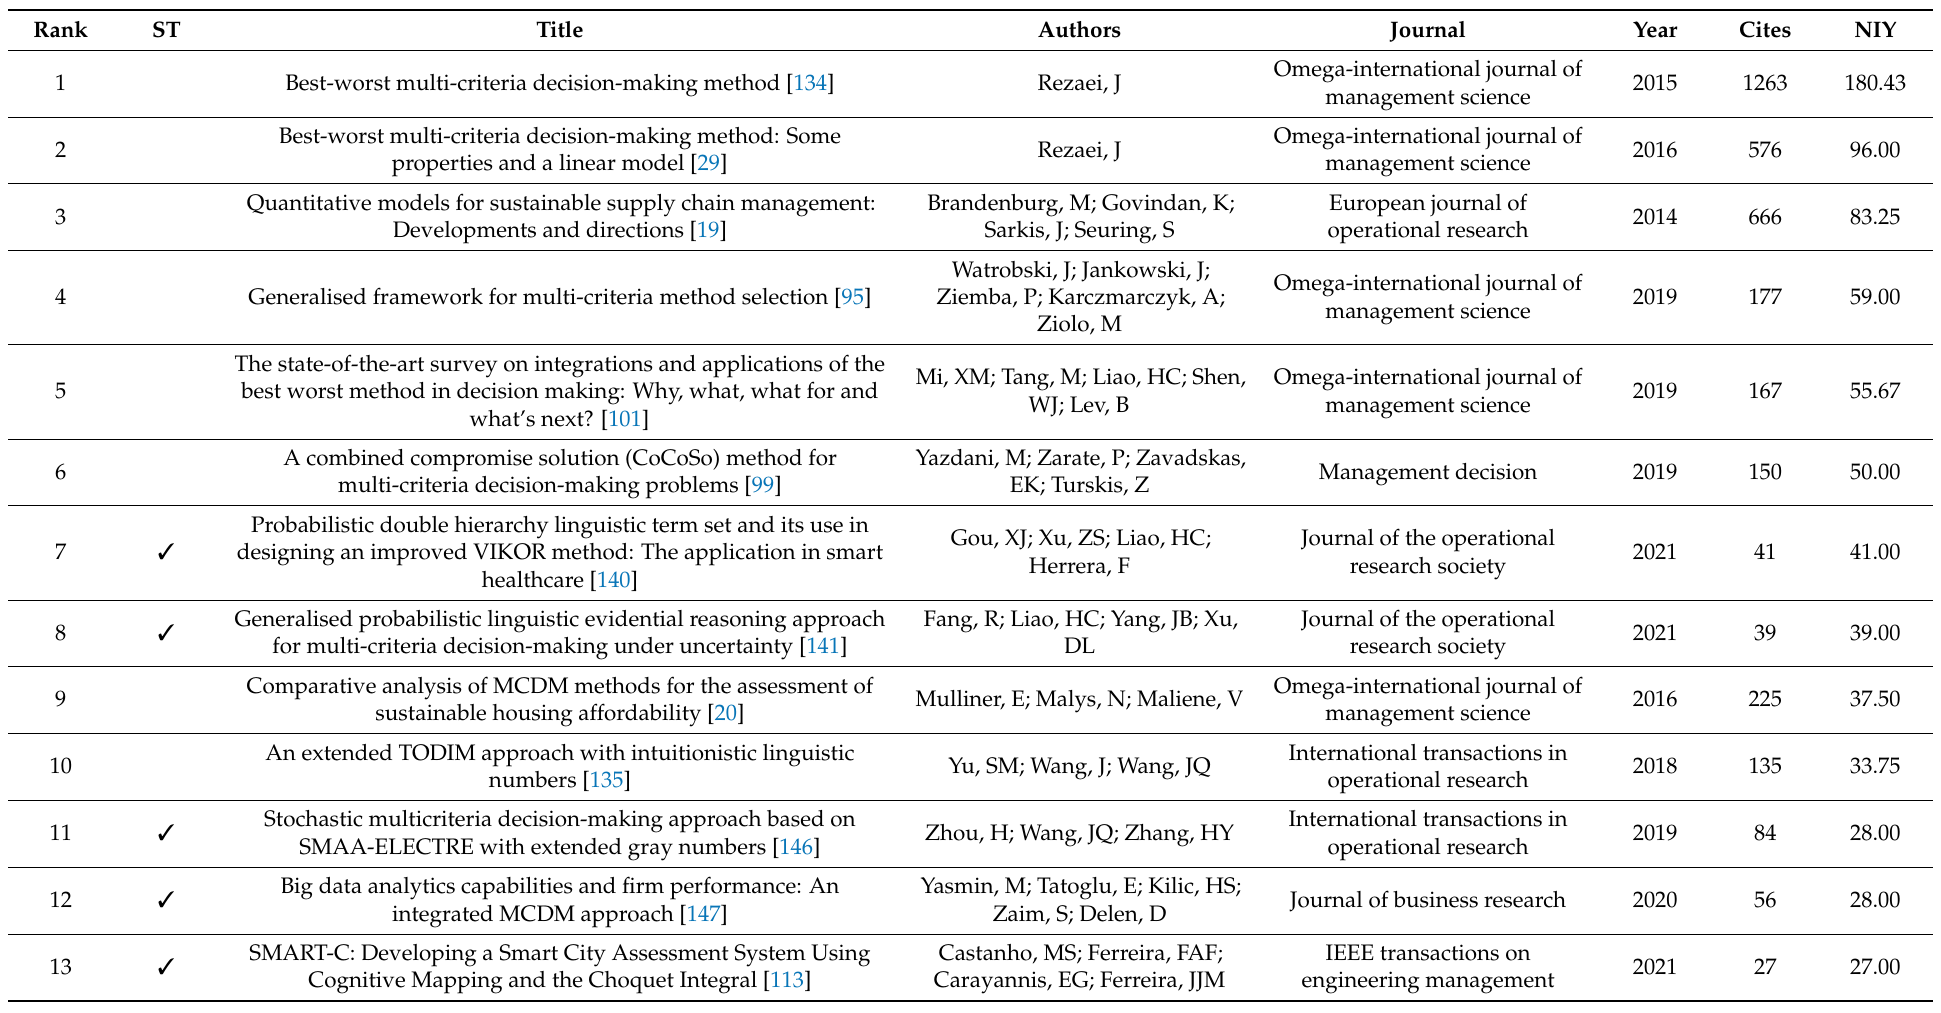
Table A4. Top 25 articles by NIY. Subperiod 1